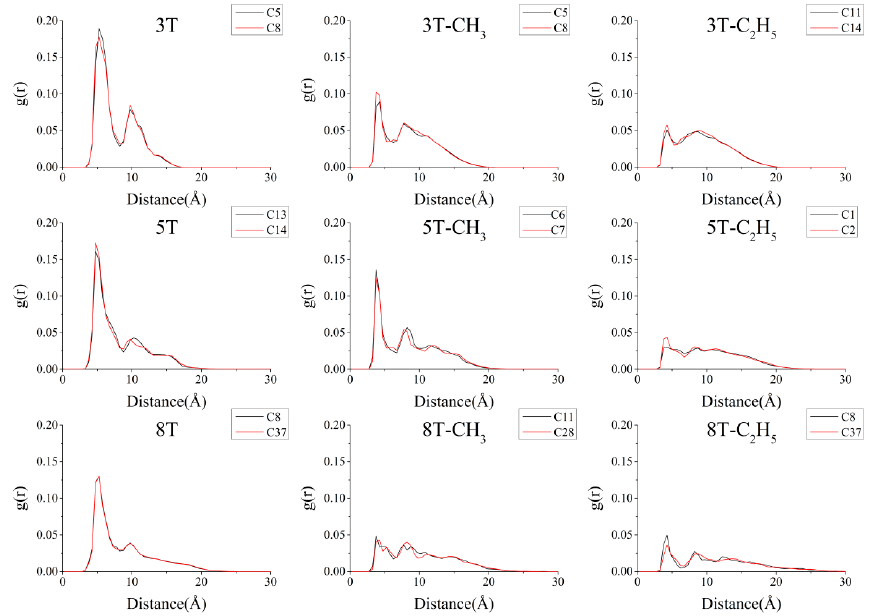
Figure 5. Radial distribution function between the carbon atoms in the center of the main chains of non-, methyl-, and ethyl-substituted 3T, 5T, and 8T molecules, respectively.